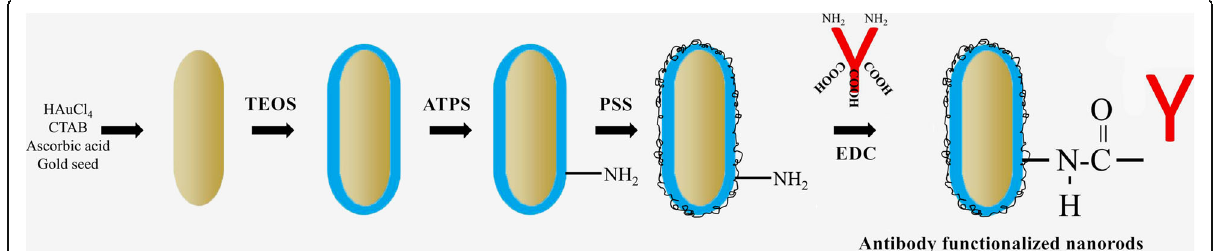
Fig. 1 Synthetic procedure of GNR-SiO 2